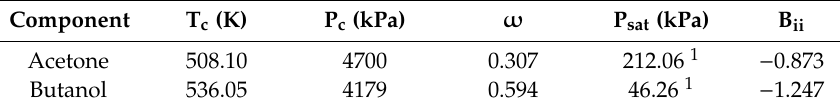
Table 2. Thermodynamic properties and parameters of pure